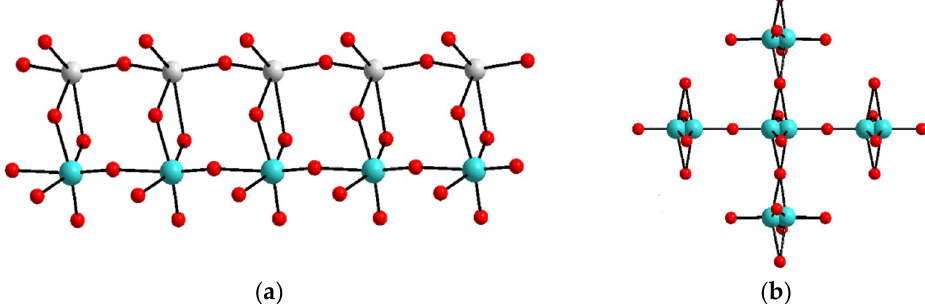
0.43 Mo 2.56 SbO 9.5 crystal.